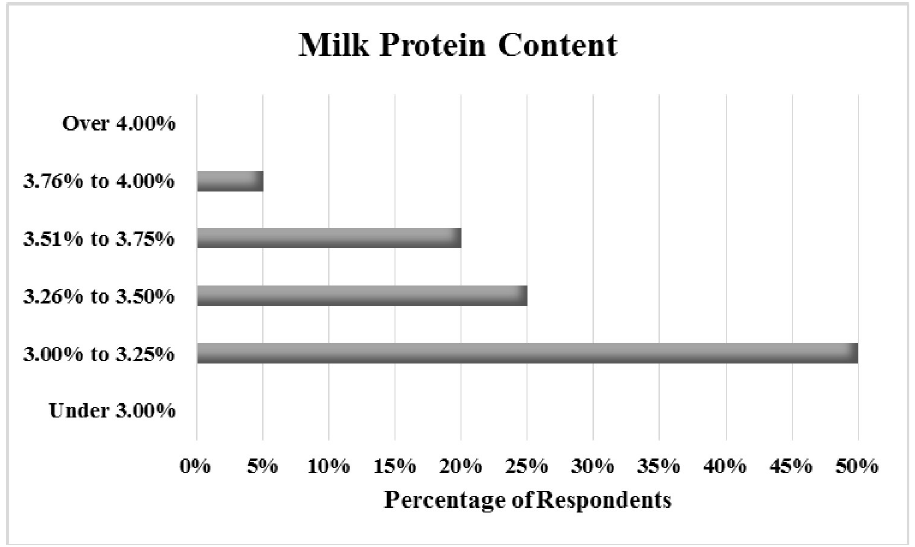
Fig 3. Percentage of respondents reporting each level of protein content.